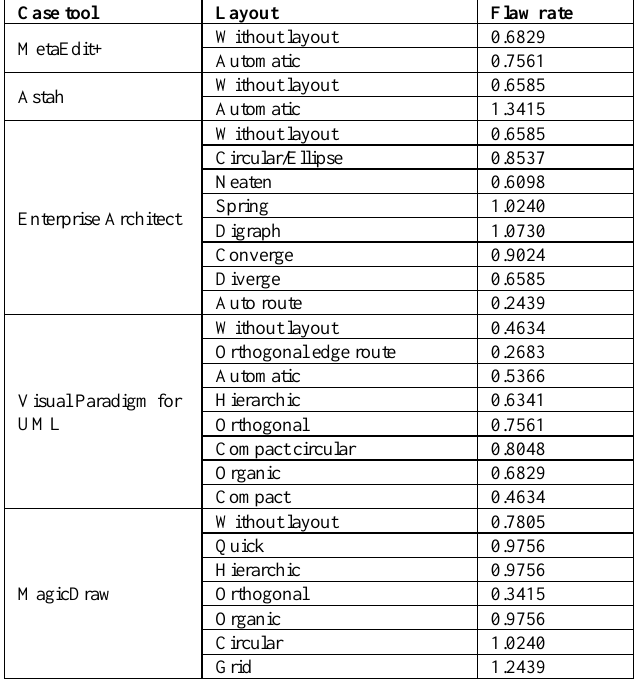
TABLE III U SE C ASE D IAGRAM F LAW R